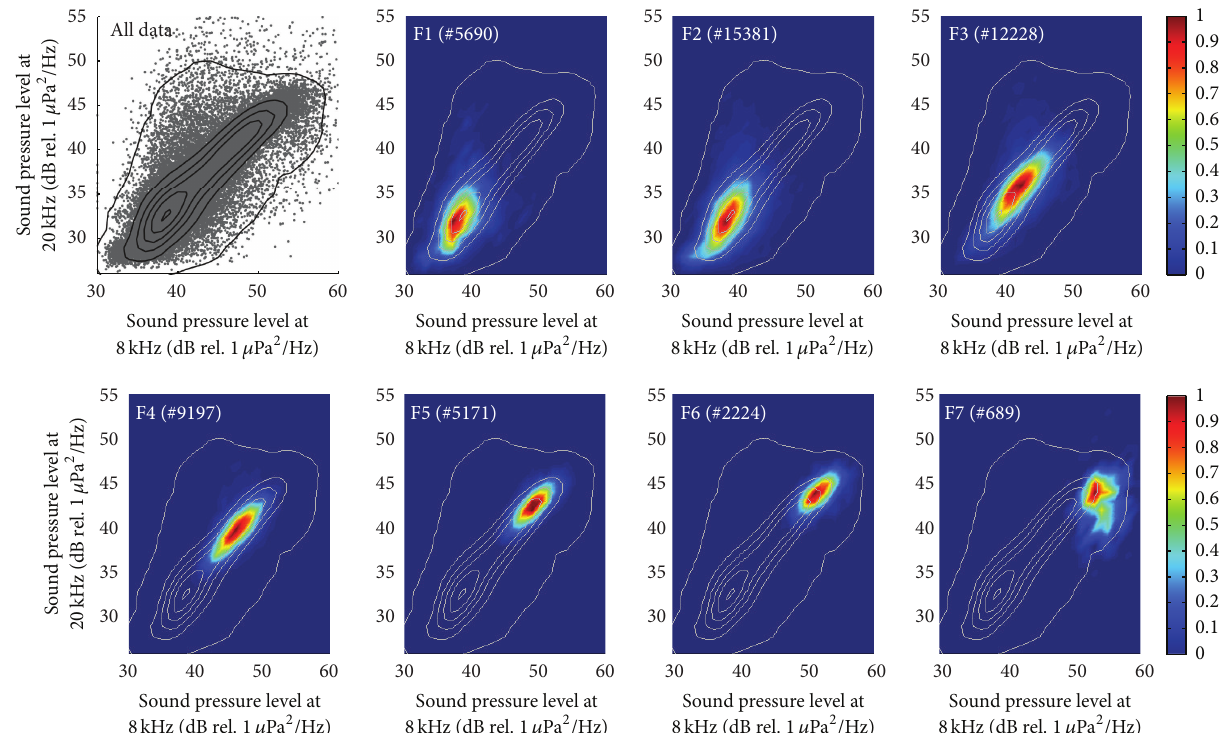
Figure 12: Bidimensional distributions of sound pressure levels at 20kHz and 8kHz. Clusters show relative frequency of the 8–20 kHz pairs for each wind speed class with respect to the contour lines of overall pairs distribution.